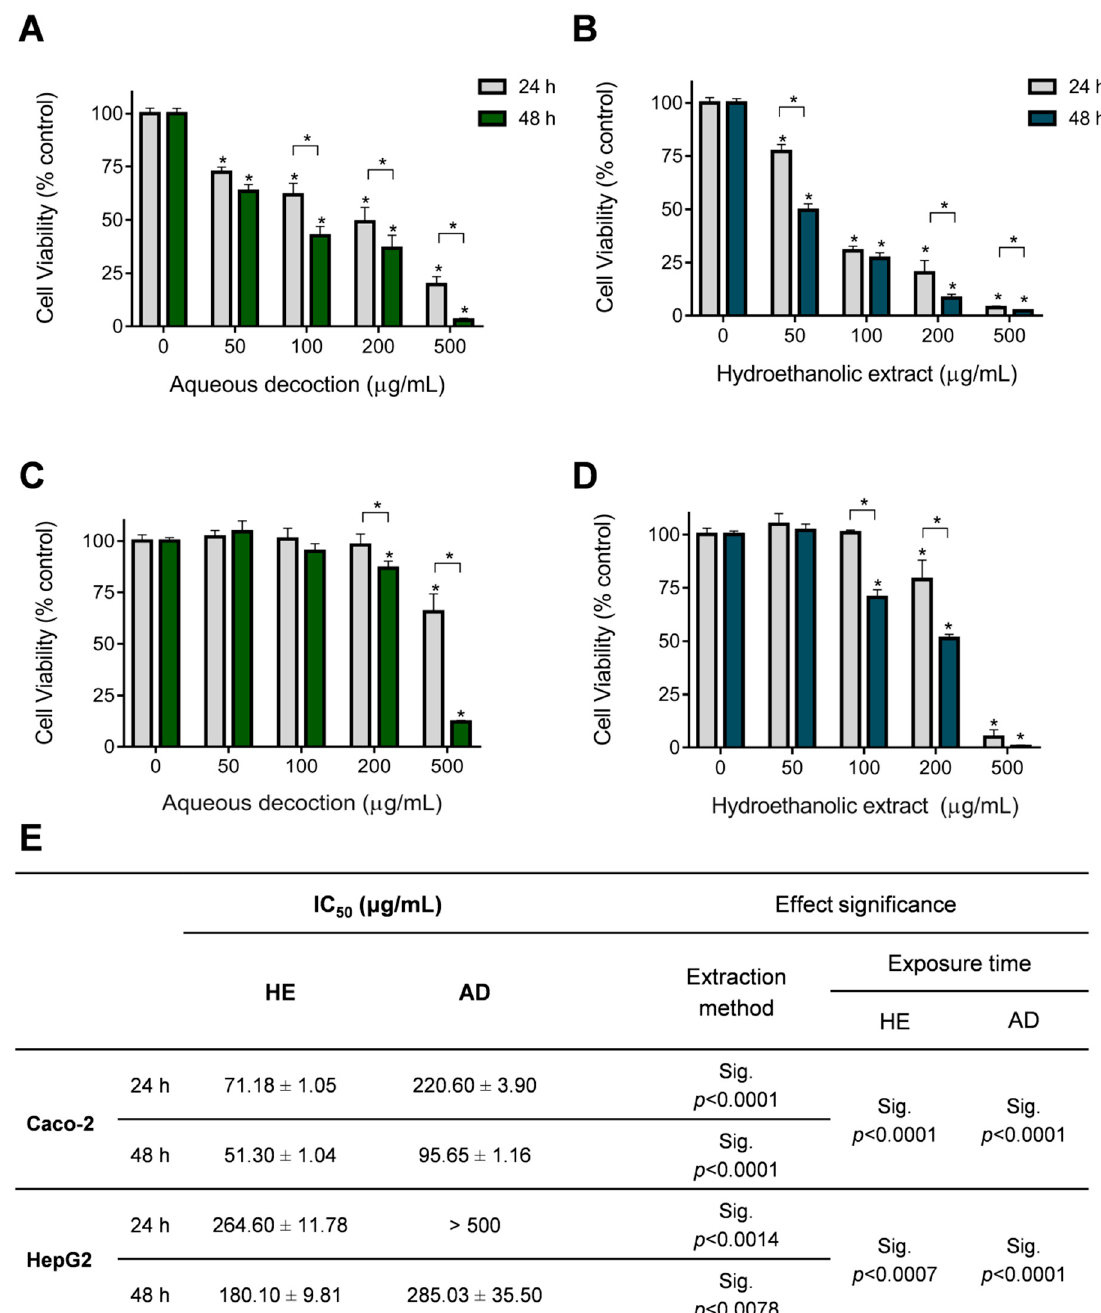
Figure 3. Anti-proliferative effect of T. mastichina extracts against Caco-2 ( A , B ) and HepG2 ( C , D ) cells. Effect of aqueous decoction ( A , C ) and hydroethanolic ( B , D ) extracts of T. mastichina after 24 or 48 h of exposure (as denoted). Results are expressed as (mean ± SD, n = 4. (*) denotes significant differences, p < 0.05. The calculated IC 50 values for Caco-2 and HepG2 cells exposed to both extracts are shown in ( E ). Abbreviation: AD, aqueous decoction; HE, hydroethanolic extract; Sig., significant; n.s., not significant.